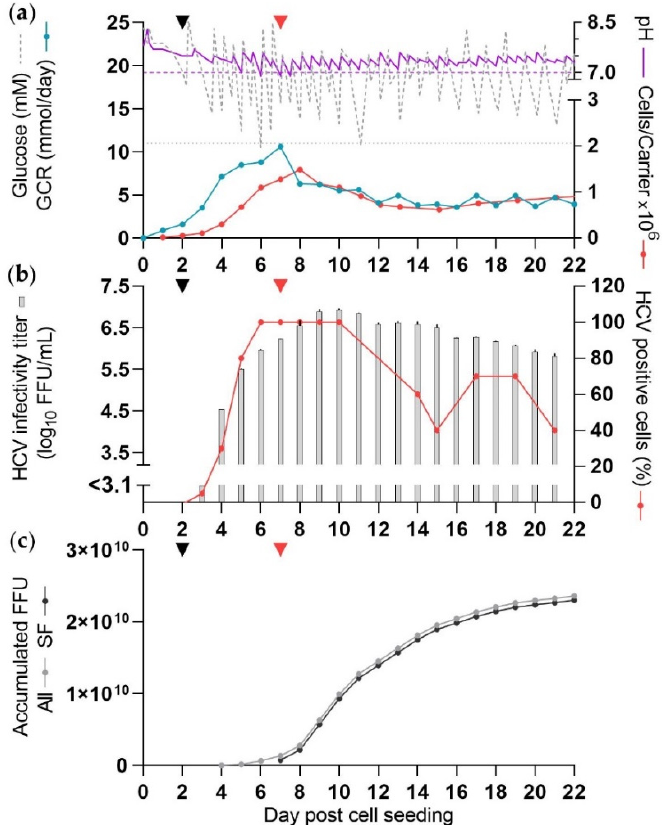
Figure 2. Production of HCV in SFM (CC-DMEx1-SFM 1 ). The culture was seeded and infected at 2 dpcs (black arrow), as described in Figure 1. Purple dashed line: pH 7, grey dotted line: 11 mM glucose. At 3 dpcs medium was exchanged in the evening and from 4 dpcs medium was exchanged each morning. From 4 dpcs glucose and/or NaHCO 3 solution was added as required and glucose concentration and pH were measured as described in Figure 1. Carriers were sampled daily until 13 dpcs and then less frequently. From 6 dpcs (evening) the culture was maintained in SFM (red arrow). ( a ) Glucose concentration, pH, GCR, and cells/carrier. ( b ) HCV infectivity titer and percentage HCV NS5A positive cells. ( c ) Accumulated FFU, calculated according to harvest volumes of 450 mL.